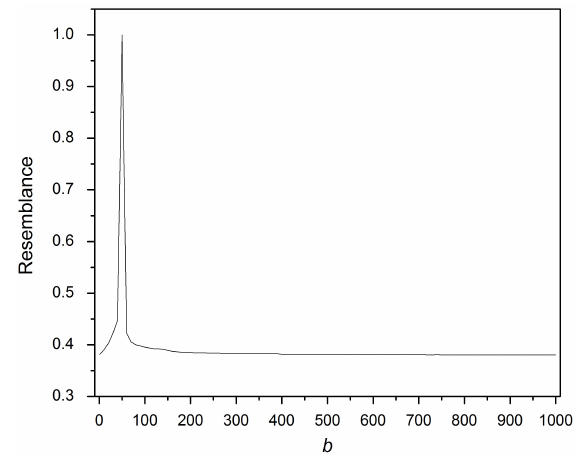
Figure 10. Effect of b on